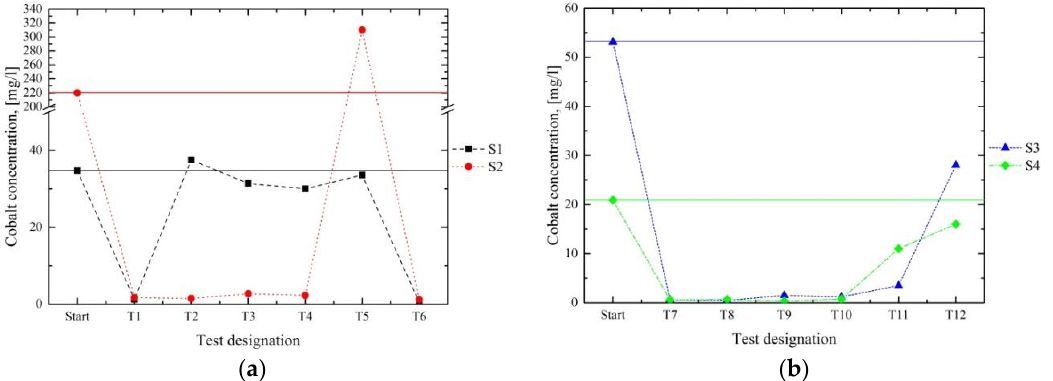
Figure 7. Concentration of cobalt in the initial solutions (start, continuous line) and in the filtrates of series 1 ( a , T1 – T6) and series 2 ( b , T7 – T12) [3].